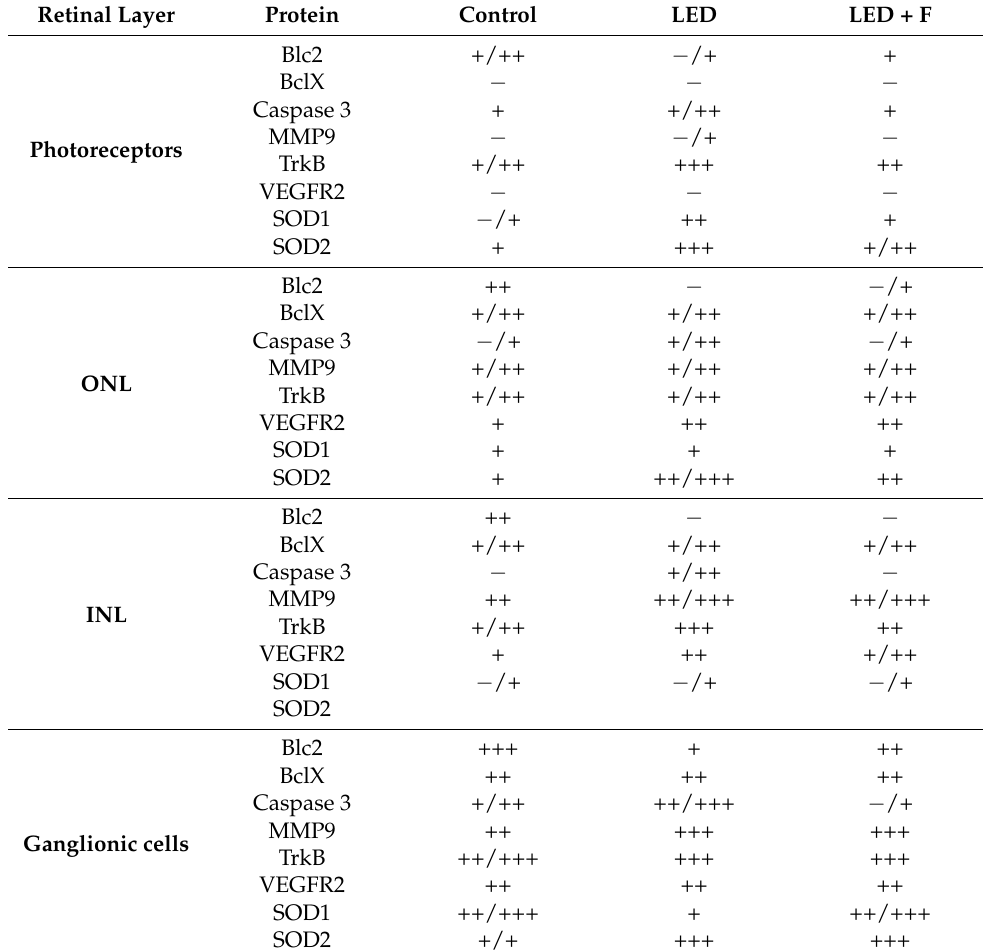
Table 4. Variations in the intensity of immunostaining in the control and the two experimental